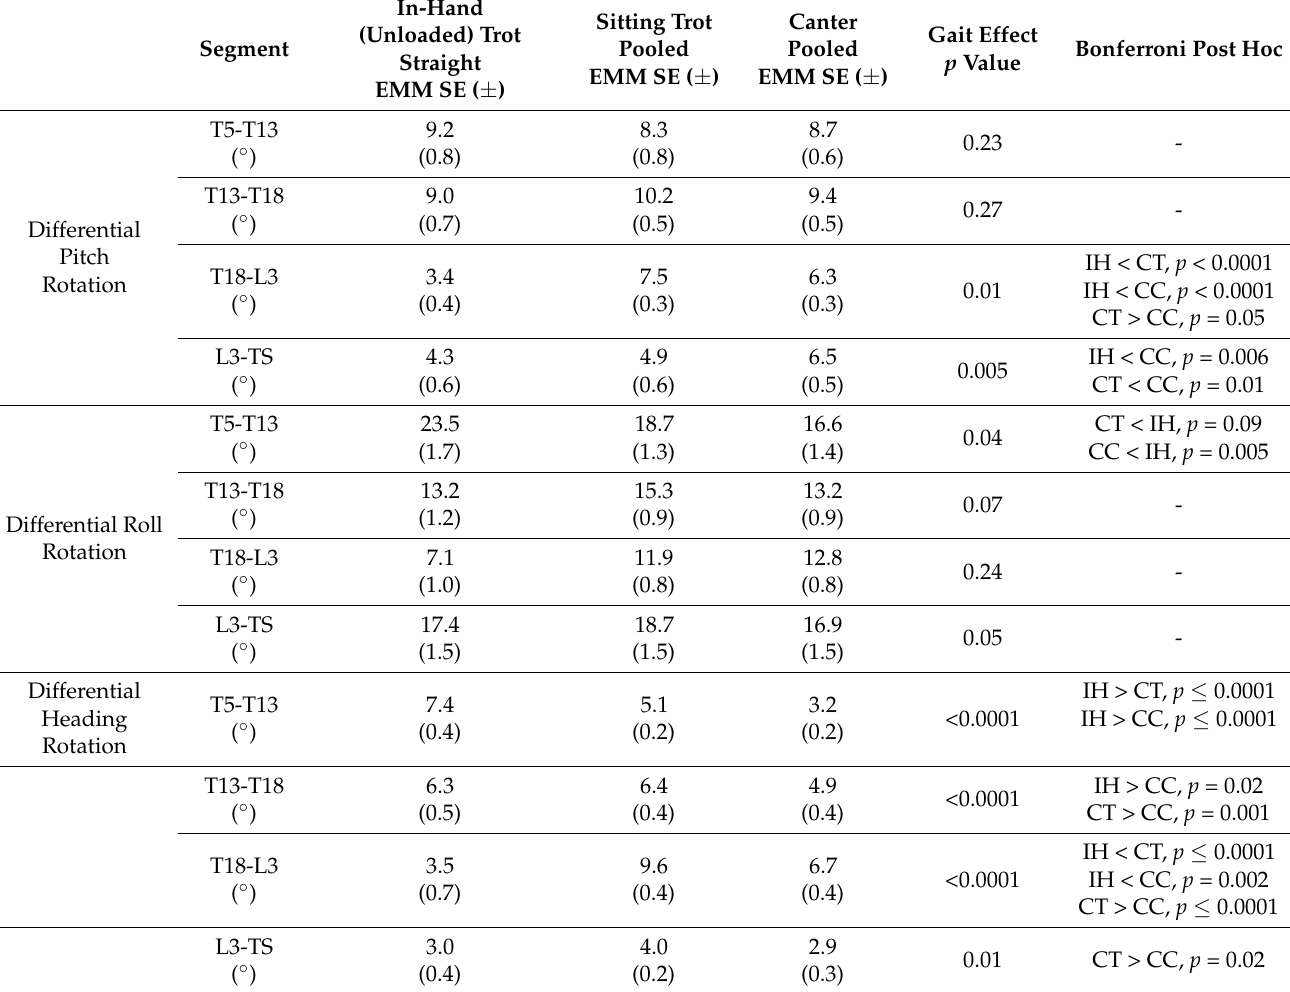
Table 1. Display of the estimated marginal mean (EMM) ± standard error (SE) for differential pitch, roll and heading rotational values for the thoracolumbosacral spine in the unloaded condition (in-hand (IH)), and ridden conditions (collected trotted trot (CT) and collected canter (CC)) from 33 straight trot strides and 45 straight canter strides. Table showing gait effect and outcome of Bonferroni post hoc tests ( p ≤